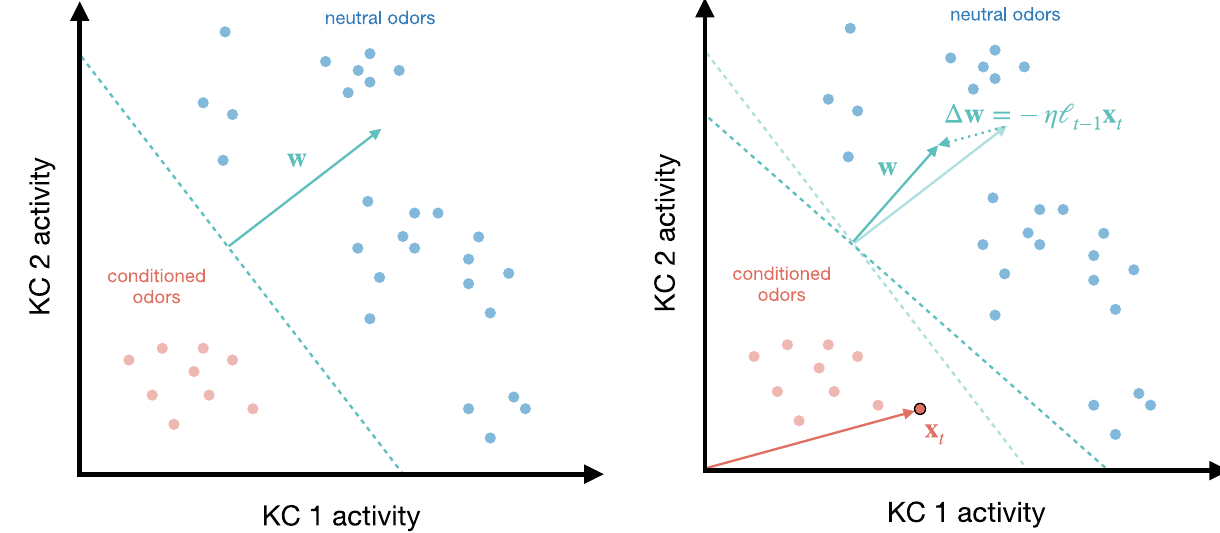
Fig 2. Linear separation of odors in the space of KC activities. Left: Illustration of the hyperplane H ¼ f x : w � x ¼ b g (dashed teal line) in the space of KC activities that separates conditioned odor responses from neutral odor responses. Each light red (resp. blue) dot denotes the KC response to a conditioned (resp. neutral) odor. The teal arrow denotes the vector of KC-MBON synaptic weights w , which is translated to show that it is orthogonal to the hyperplane H . Right: Co-activation of the KCs and the DAN weakens the synaptic weights w . The KC activities x t are denoted by the dark red dot . The hyperplane H rotates to remain orthogonal to w . The change in with black border. The change of the synaptic weights Δ w is in the direction − x t bias Δ b , which translates the hyperplane, is not depicted.